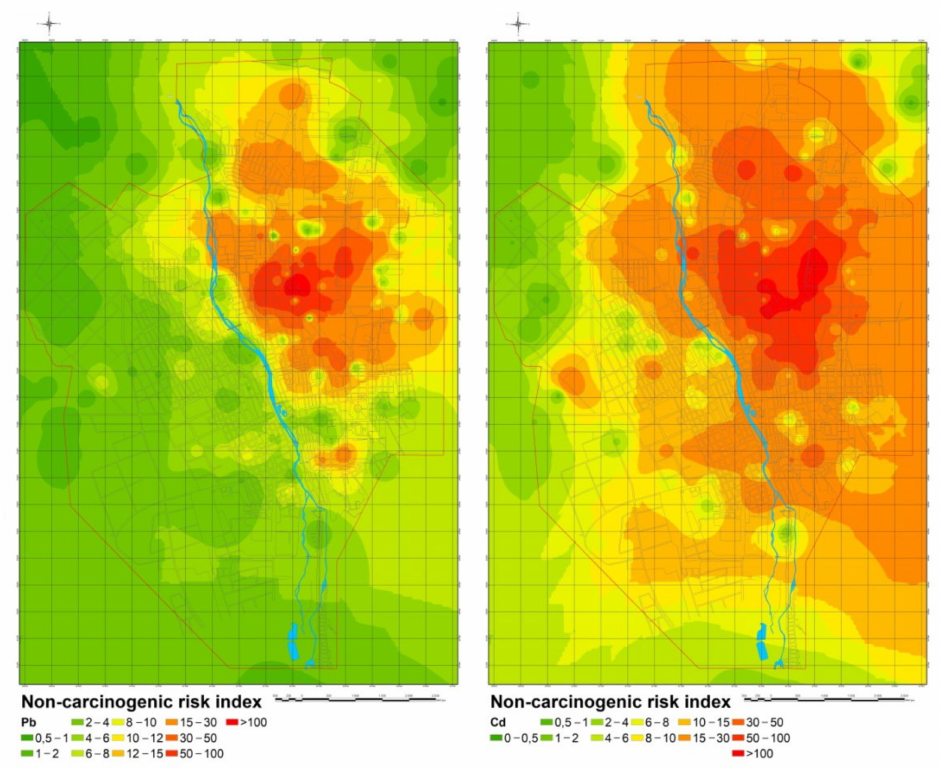
Figure 6. Non-carcinogenic risk index maps for lead and cadmium for the territory of Vladikavkaz. For the oral intake of heavy metals from the soil into the human body, the values of the carcinogenic risk index do not exceed one for all the studied elements, except lead and 0.4 for cadmium. At the same time, for non-carcinogenic risk, the index values are significantly higher than one in the areas of the greatest contamination for cadmium and